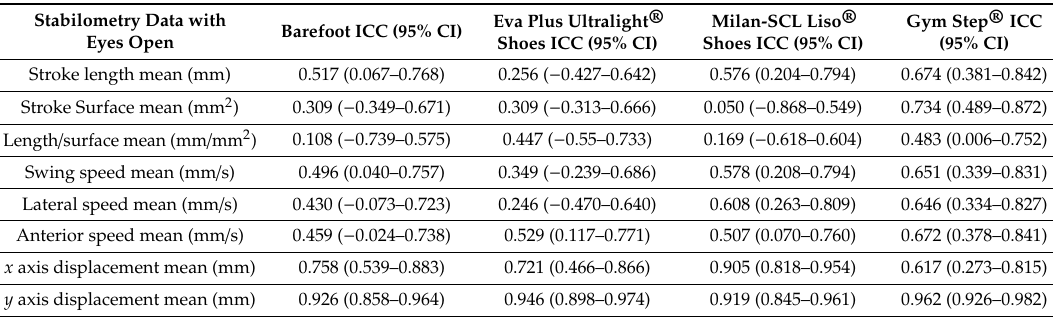
Table 3. Reliability of the stabilometry data with eyes